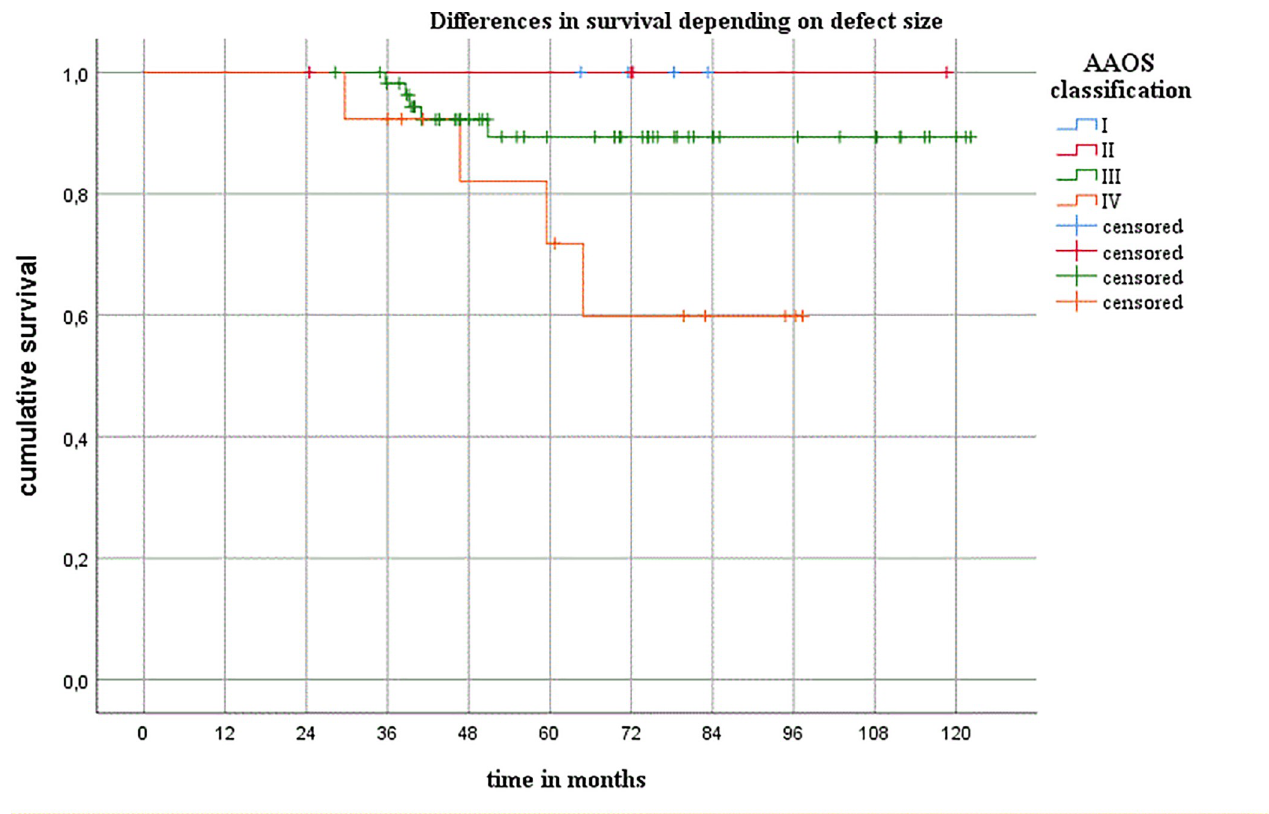
Fig 2. Differences in survival relative to the defect size. AAOS, American Academy of Orthopaedic Surgeons.